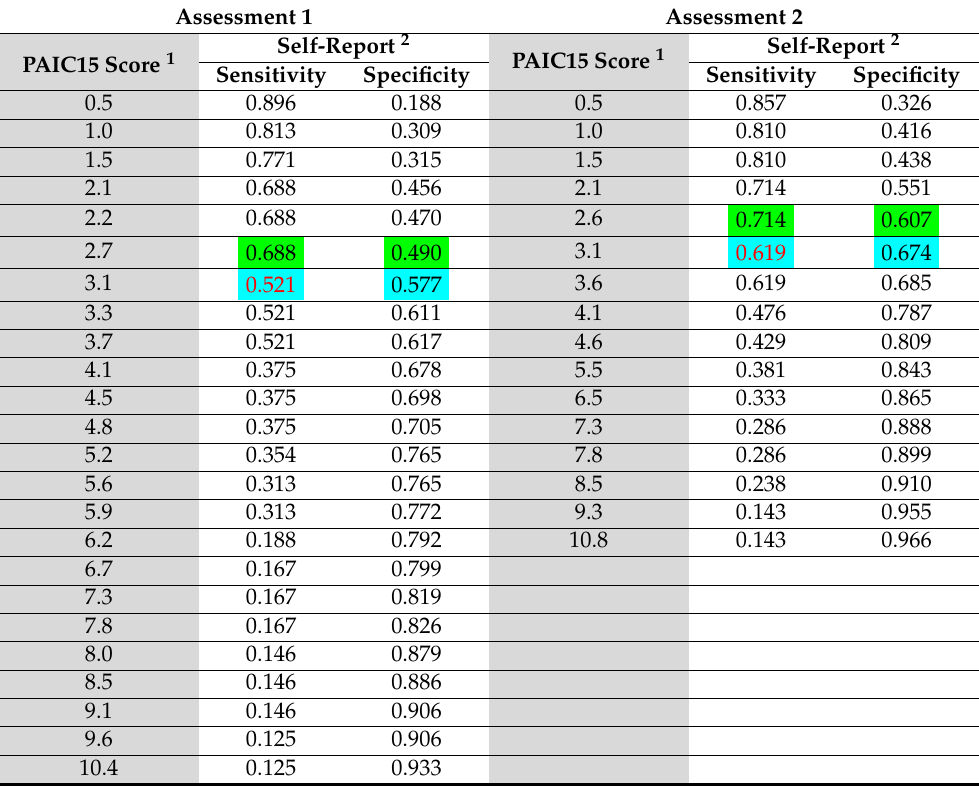
Table 7. Sensitivity and specificity of PAIC15 cut-offs against